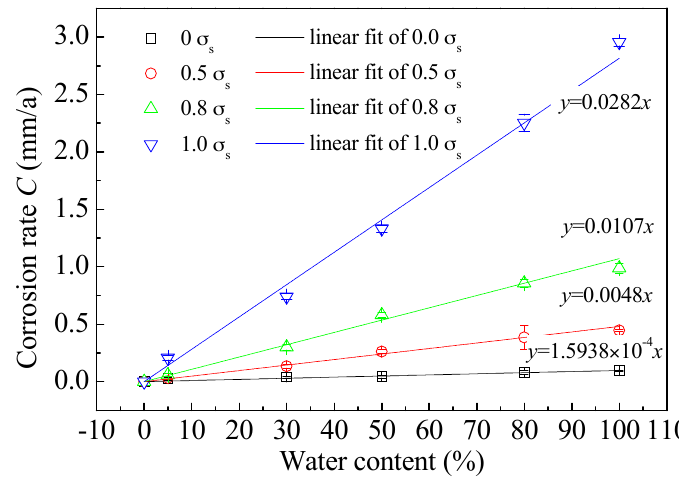
Figure 8. Corrosion rates of L80 steel and their fittings as a function of water content under different preloading stress.